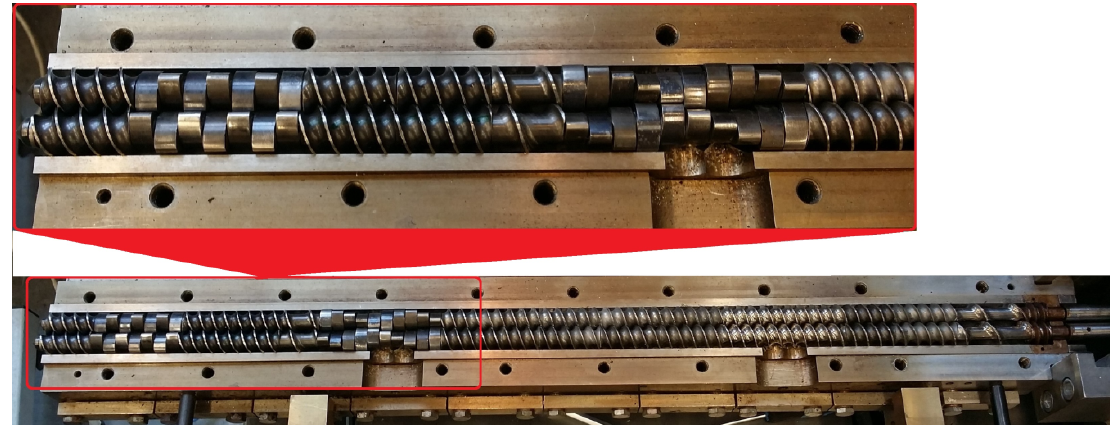
Figure 1. View of the extruder open plasticizing system with used processing screws.